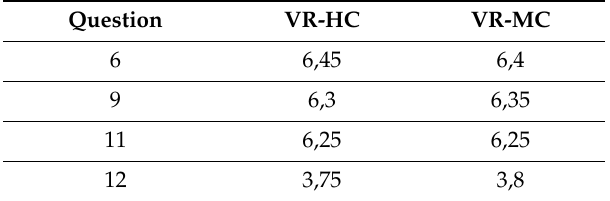
Table 2. Comparison of the mean of Questions 6, 9, 11, 12, between the VR-HC and VR-MC systems.